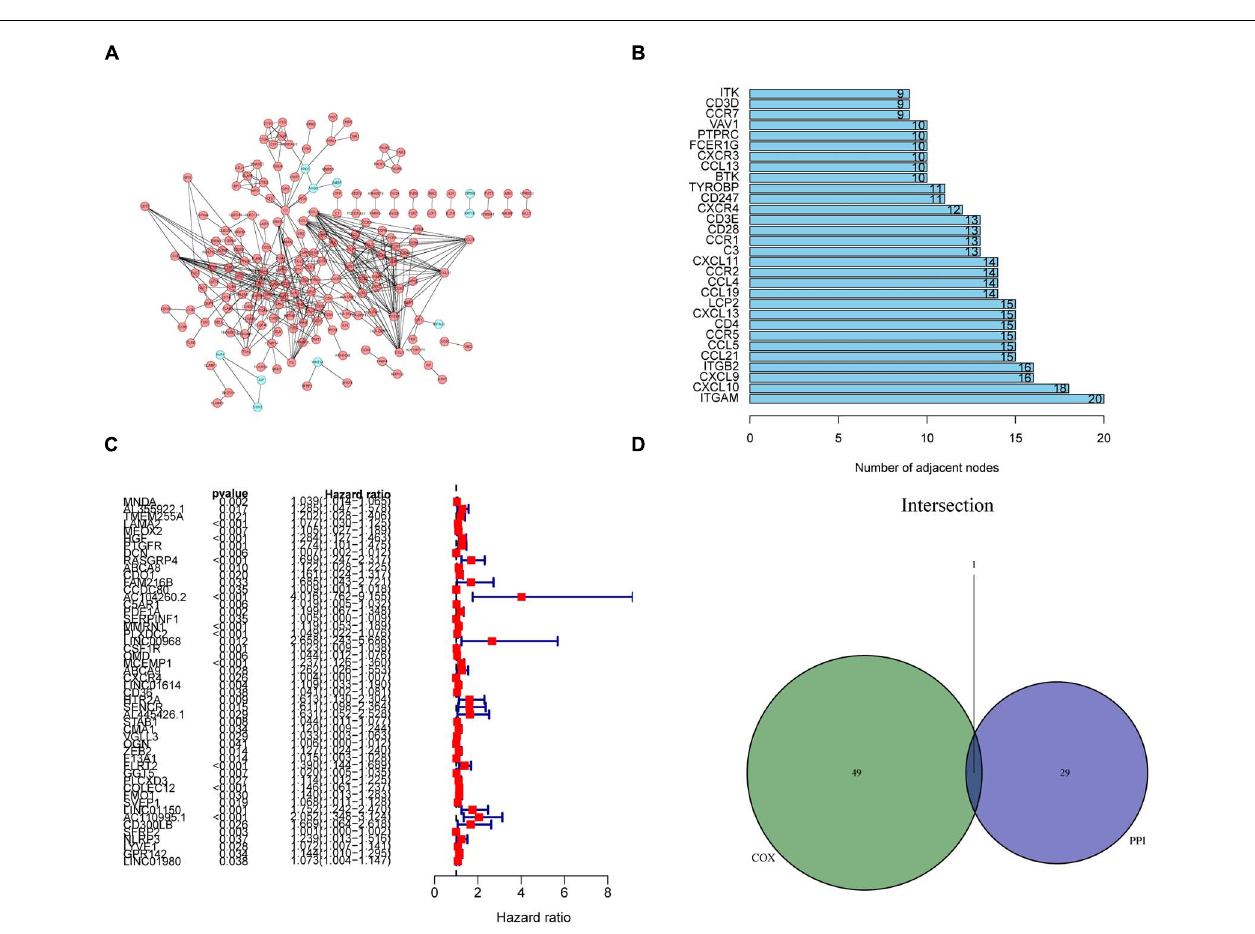
GC cells ( Figure 9 ). Immune cells such as memory B cells, resting dendritic cells, CD8+ T cells, monocytes, and